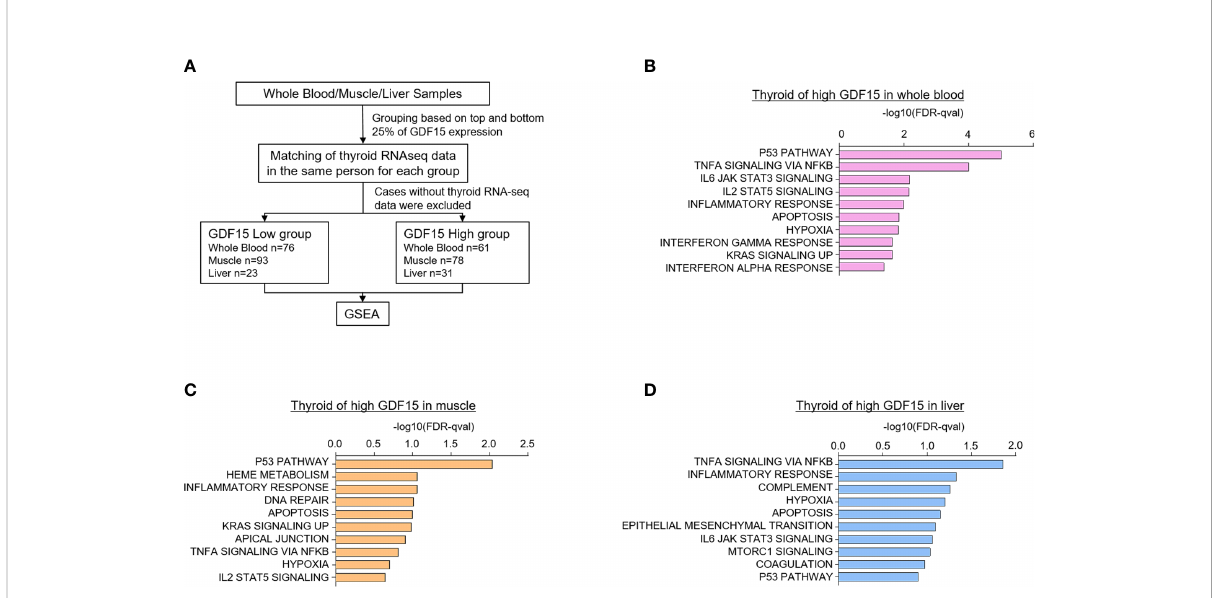
FIGURE 2 Upregulated gene sets of the thyroid gland according to high GDF15 expression of whole blood, muscles, and liver. (A) Schematic diagram of the analysis algorithm. (B – D) Representative upregulated gene sets according to high GDF15 expression of whole blood (B) , muscle (C) , and liver (D) . Gene set enrichment analysis was performed using a hallmark gene set, and all data were nominal p-value < 0.05 and false discovery rate (FDR) q-value <